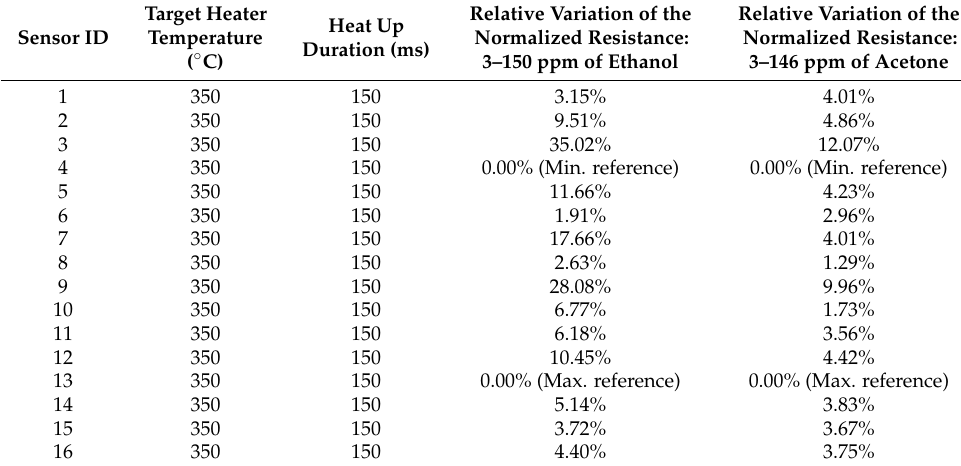
Table 2. Configuration parameters of the 16 MOX gas sensors used in the eNose and maximum relative variation of the normalized resistance of the sensing layer during the detection of ethanol and acetone. Target Heater Relative Variation of the Relative Variation of the Heat Up Sensor ID Temperature Normalized Resistance: Normalized Duration (ms) ( ◦ C) 3–150 ppm of Ethanol